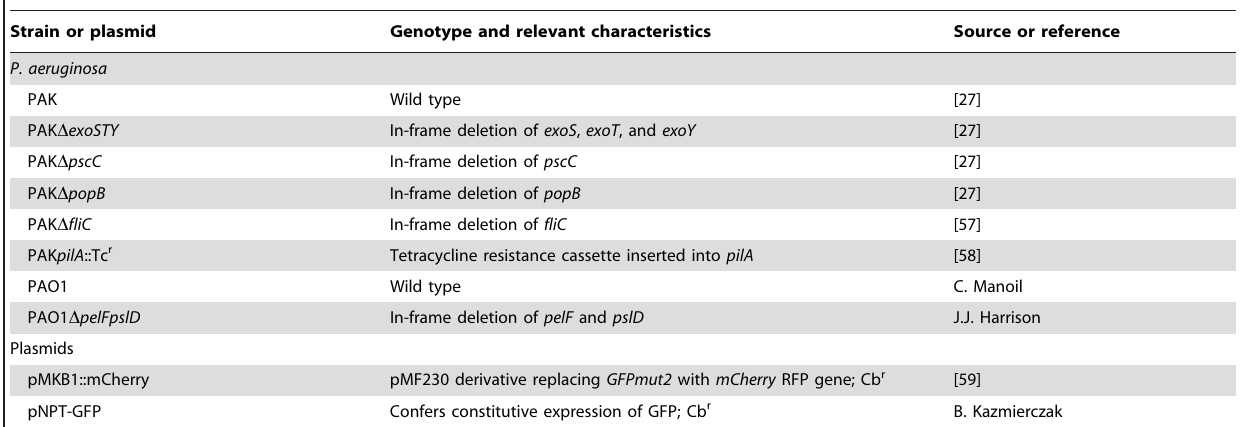
Table 1. Strains and plasmids used in this study.